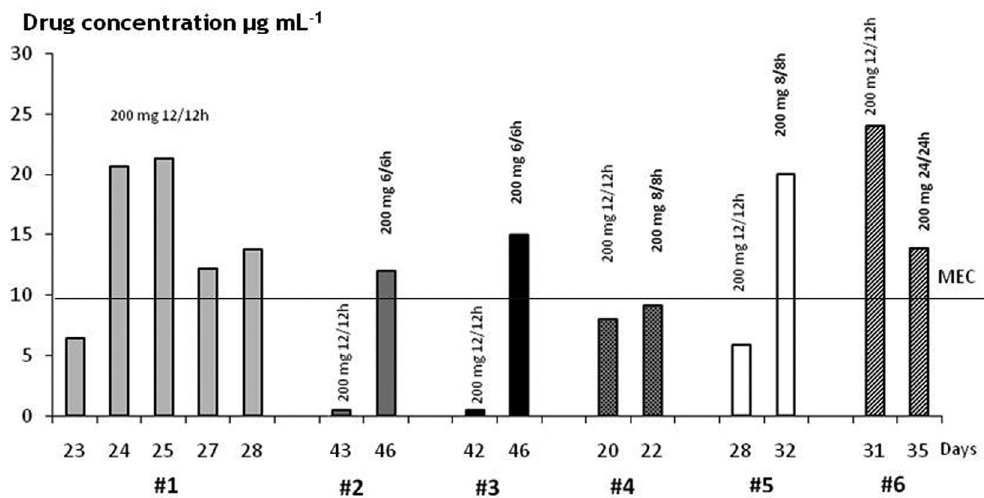
Figure 2 - Antimicrobial therapy was started at an empirical dose regimen (fluconazole 200 mg twice daily, fast infusion) and was altered based on thera- peutic drug monitoring of six burn patients with fungal infection. Trough plasma levels were obtained at different days after the accident. Abbreviation: minimum effective concentration (MEC > 10 µg/mL).